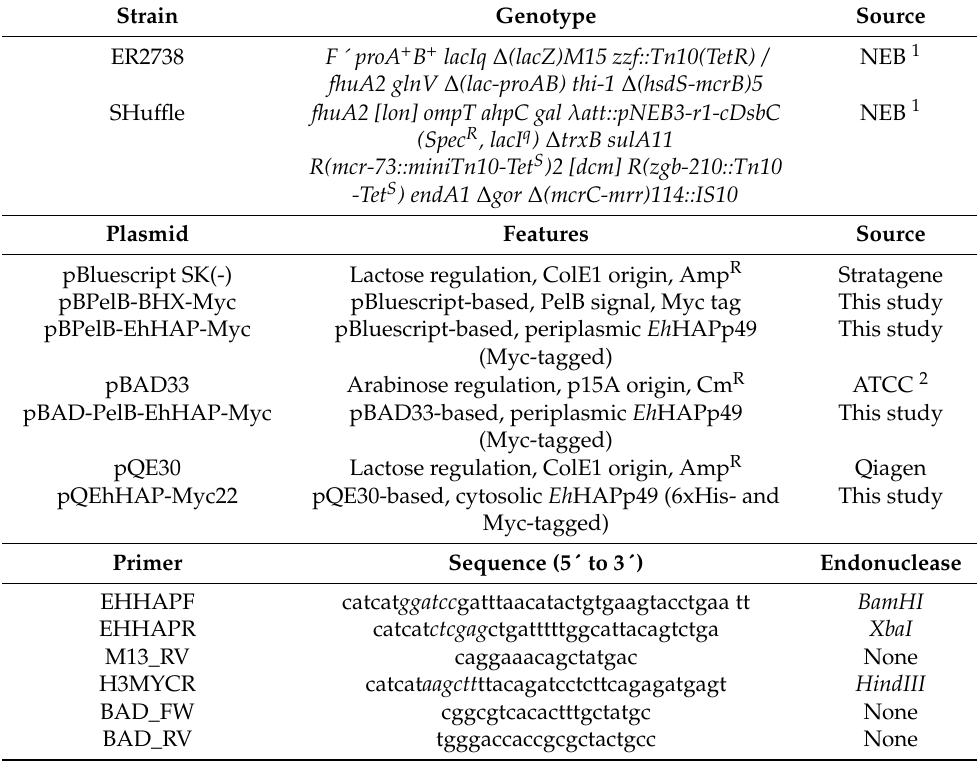
Table 3. Strains, plasmids, and primers used in this study. Strain Genotype Source